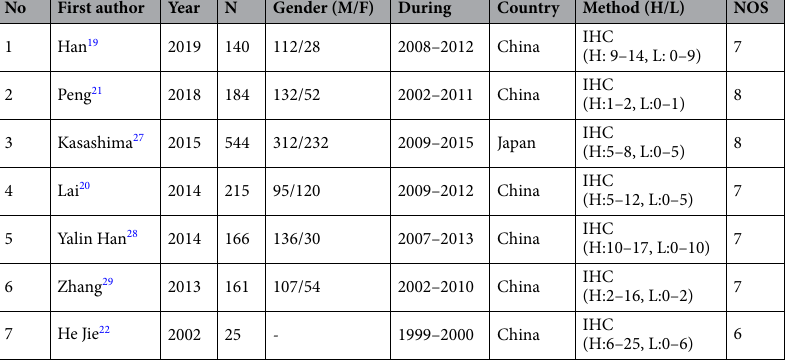
Table 1. Main characteristics of the eligible studies. IHC immunohistochemistry, H high expression, L low expression.